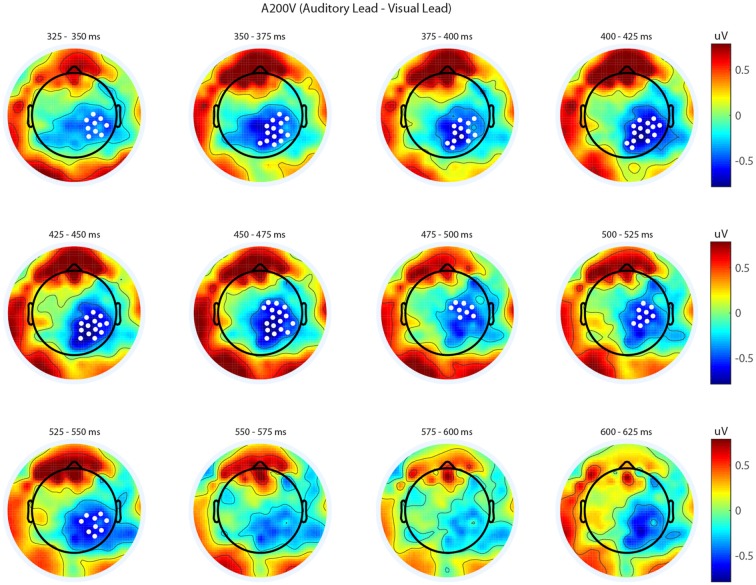
Spatiotemporal representation of evoked differences in the A200V condition. Cluster permutation testing indicated there was a single significant cluster (p = 0.0019). Voltages indicated are the difference between when trial t−1 was auditory leading and when trial t−1 was visual leading. Warm colors indicate voltage was greater when the preceding trial was an audio-leading trial. Cool colors indicate voltage was greater when vision-lead on the preceding trial. White circles indicate the locations of electrodes forming a significant cluster.